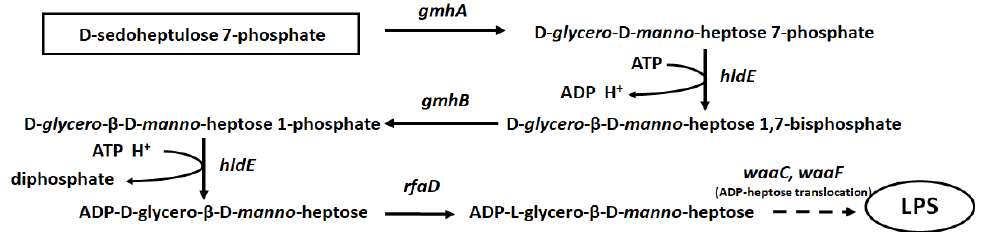
Figure 2. Biosynthesis of ADP-heptose from sedoheptulose 7-phosphate and its translocation to LPS. Disruption of any step in this pathway disturbs the incorporation of the heptose residues in the LPS structure.